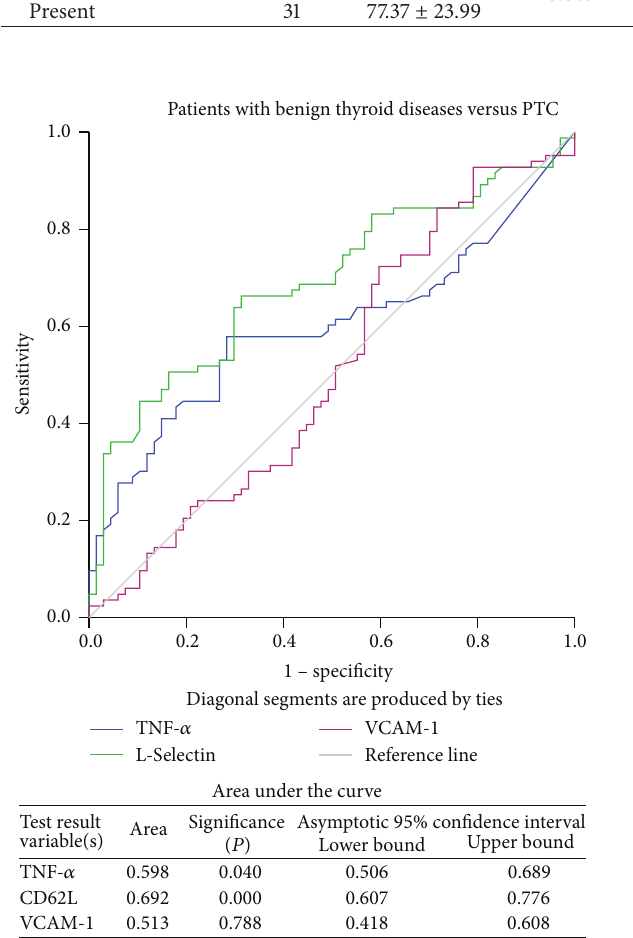
Figure 3: ROC curve for TNF- 𝛼 , L-Selectin, and VCAM-1 in patients with benign thyroid diseases versus